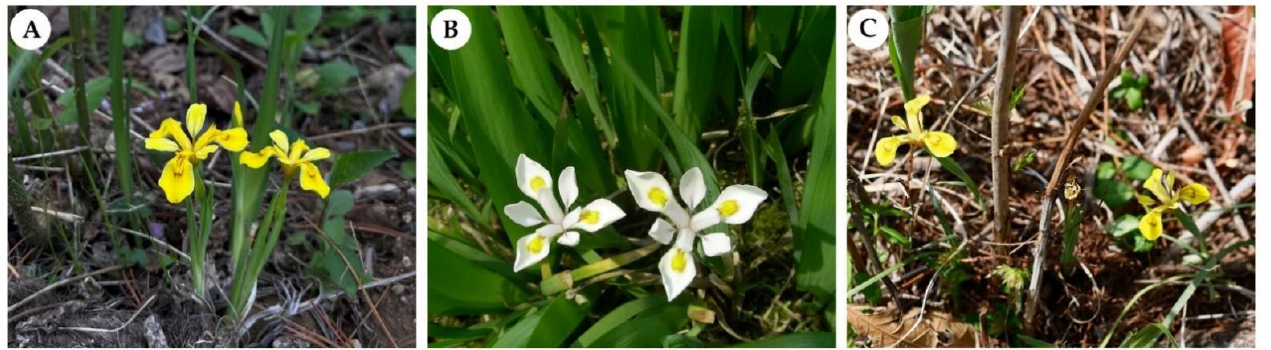
Figure 1. Morphology and habit of the three Iris species from Korea. ( A ) I. koreana , ( B ) I. odaesanensis , ( C ) I. minutoaurea .